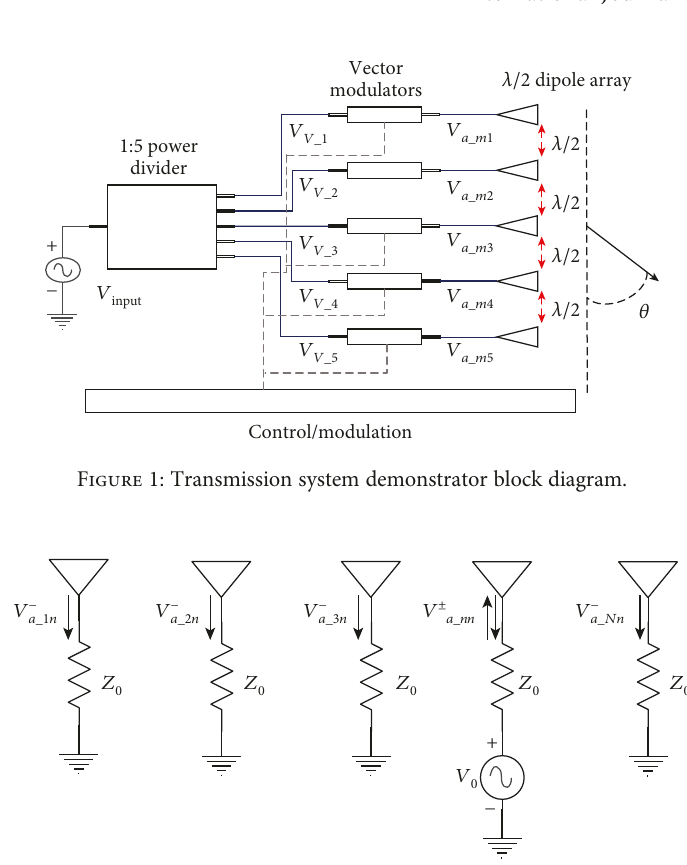
Figure 2: Geometry for obtaining the active element pattern of the element n of the array of N antennas.